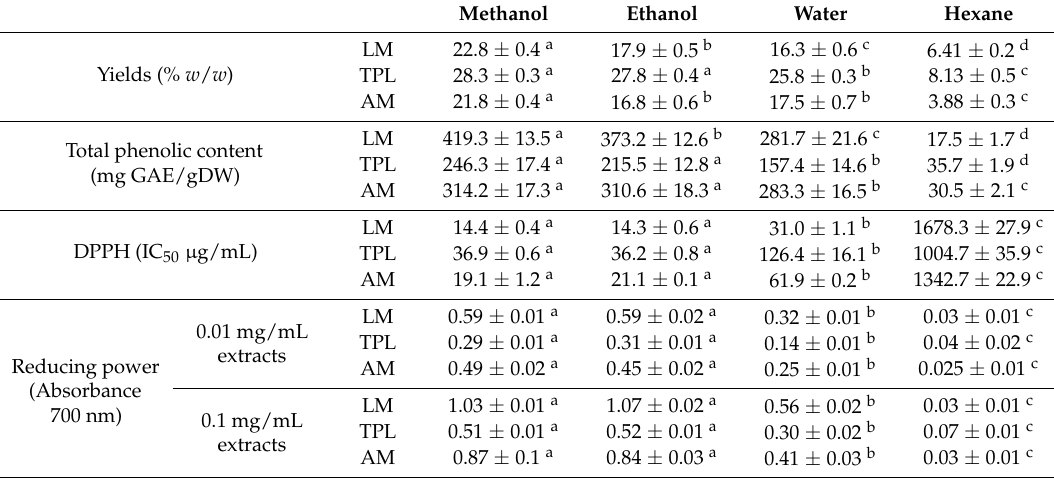
Table 1. Yields, total phenolic content, DPPH free radical scavenging and reducing power of Tasmanian pepper leaf, lemon myrtle and anise myrtle